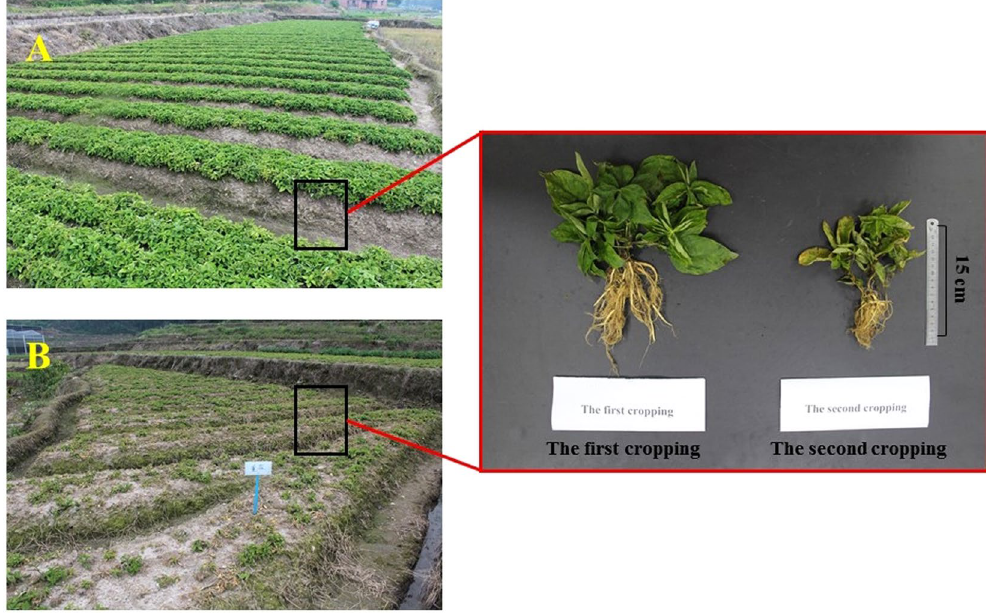
Figure 1. Photographs of above and below ground components of Radix pseudostellariae under one-year and two-year consecutive monoculture. ( A ) newly planted R. pseudostellariae , ( B ) two-year monocultured R. pseudostellariae